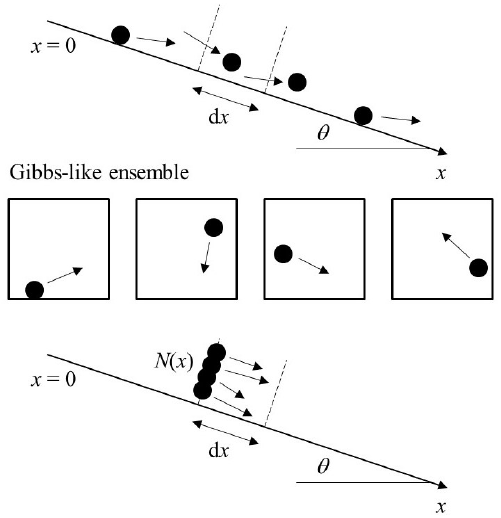
Figure B1. Schematic diagram of surface inclined at angle θ and control volume with edge length d x through which particles move, with Gibbs-like ensemble of single-particle systems leading to def- inition of the cohort of N ( x ) particles starting at the left face of the control